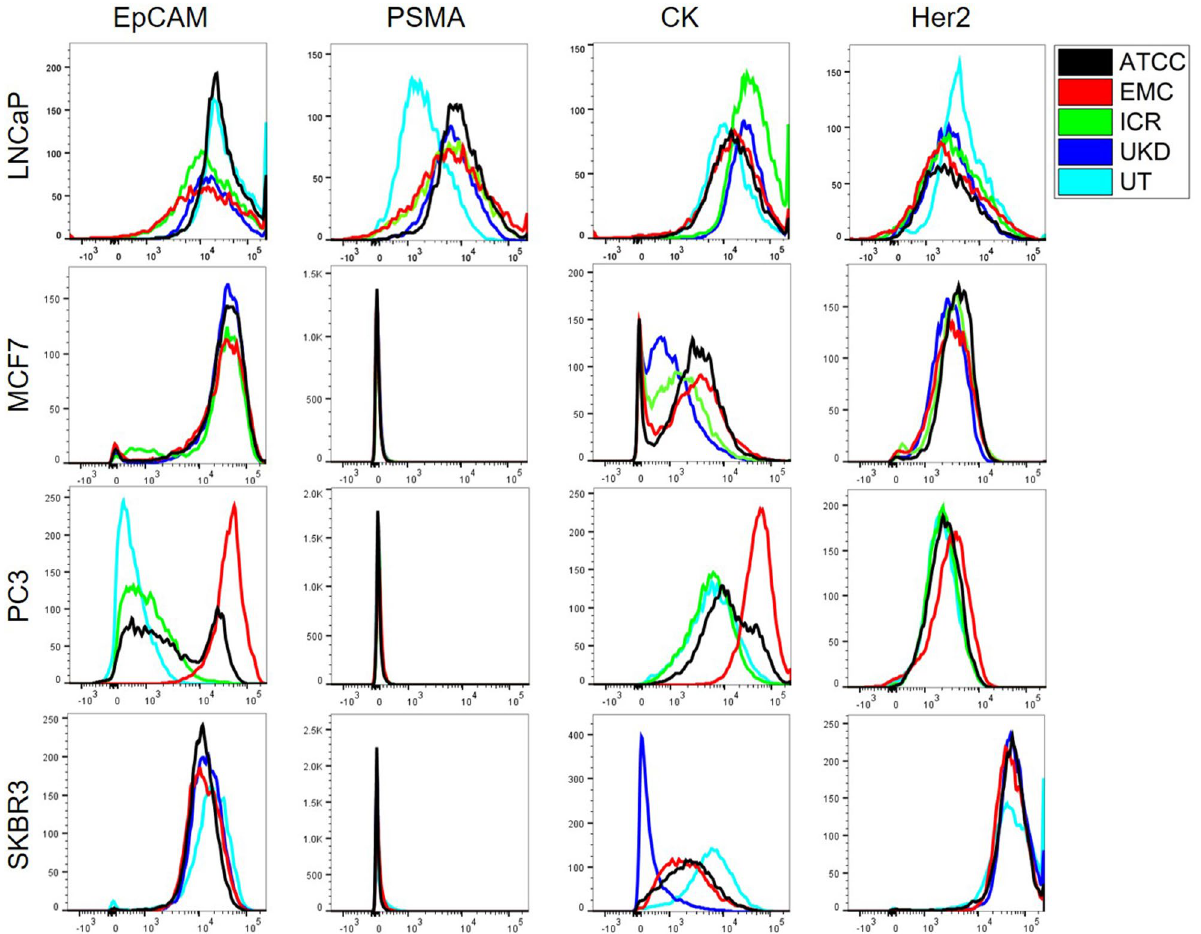
Figure 3. The expression of EpCAM, Her2, PSMA and Cytokeratin (CK) in LNCaP, MCF7, PC3 and SKBR3 from the ATCC, Erasmus MC (EMC), London Institute for Cancer Research (ICR), Universitätsklinikum Düsseldorf (UKD) and University of Twente (UT). Histograms of the PE signal are shown as measured using flow cytometry.